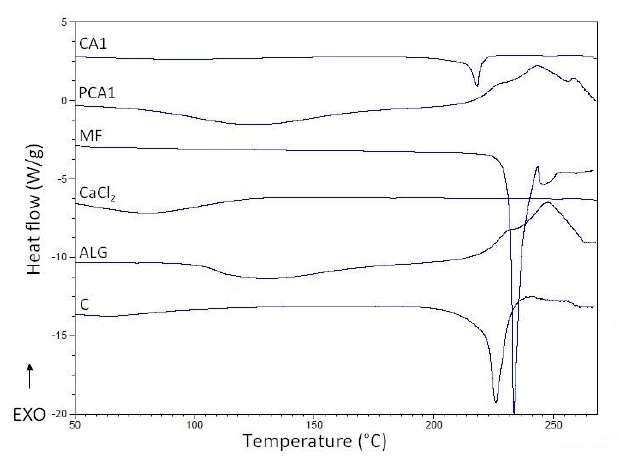
Figure 6. Differential scanning calorimetry (DSC) curves of pure sodium alginate (ALG), metformin (MF), CaCl 2 , non-modified microparticles C, microparticles PCA1, and CA1.